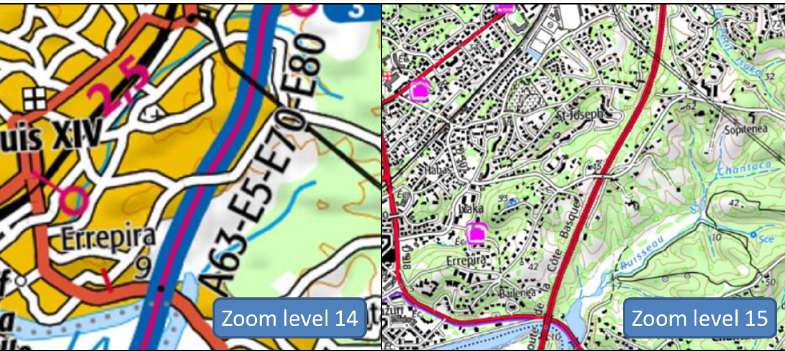
Figure 12. Two consecutive scales at zoom levels 14 and 15 where the map changes a lot, preventing pre-attentive reconciliation based on common landmarks (source: